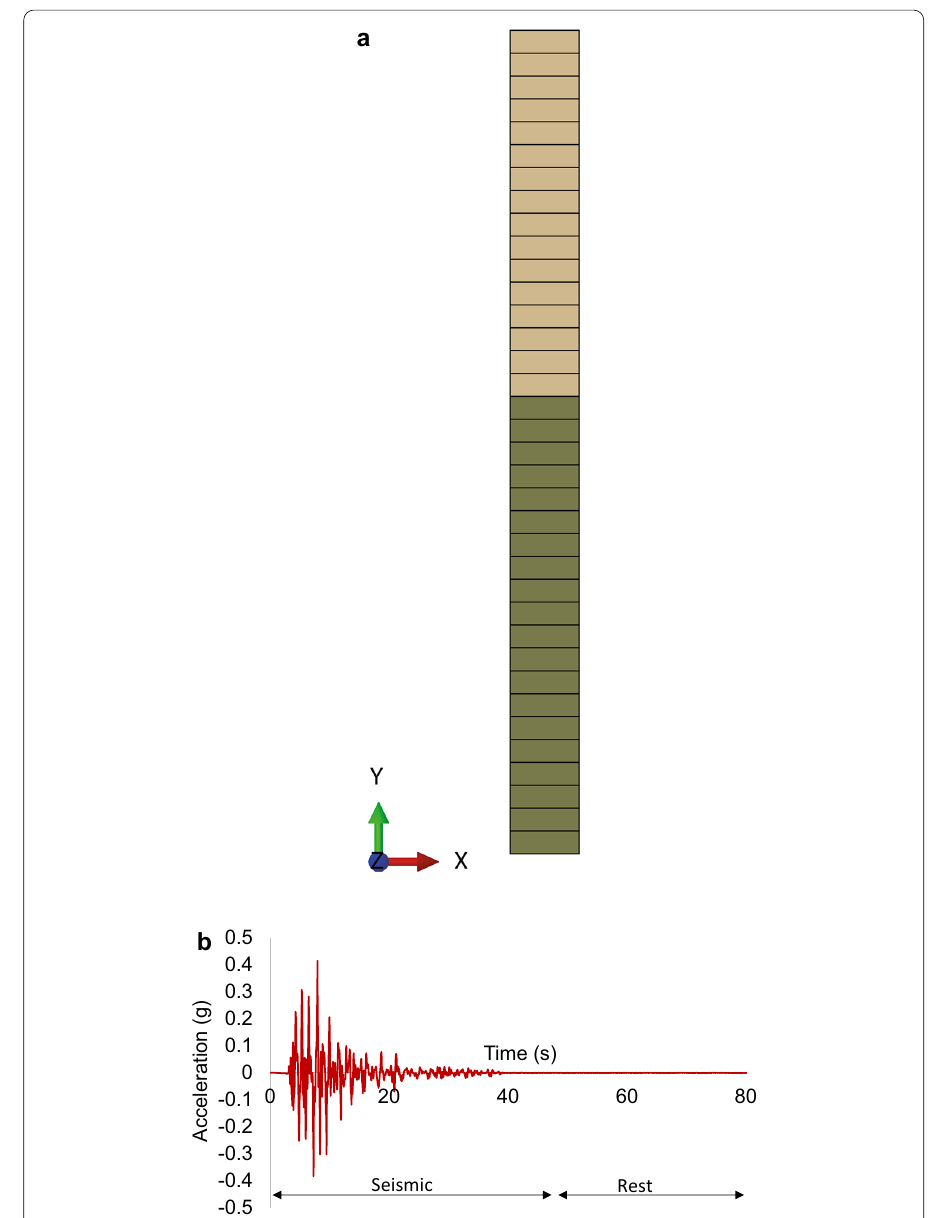
Fig. 5 Numerical model (left) and applied acceleration time history along with rest period (right)